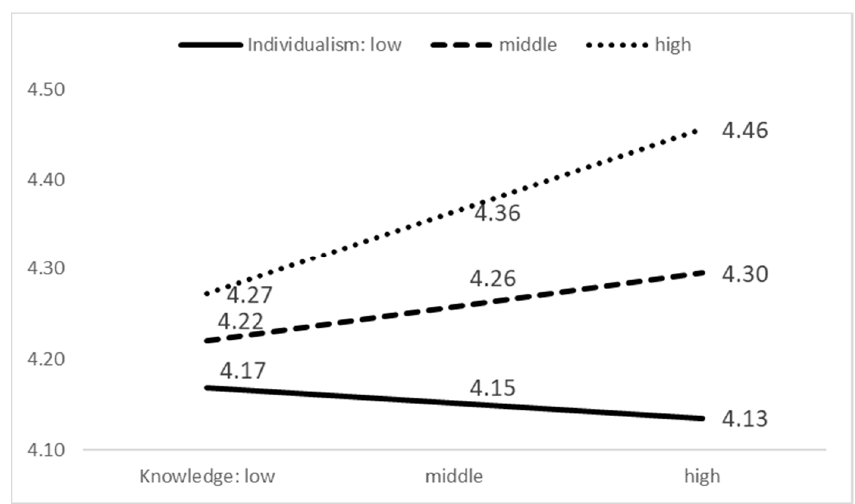
Figure 12. Knowledge (IV) × individualism (M) = skepticism (DV).